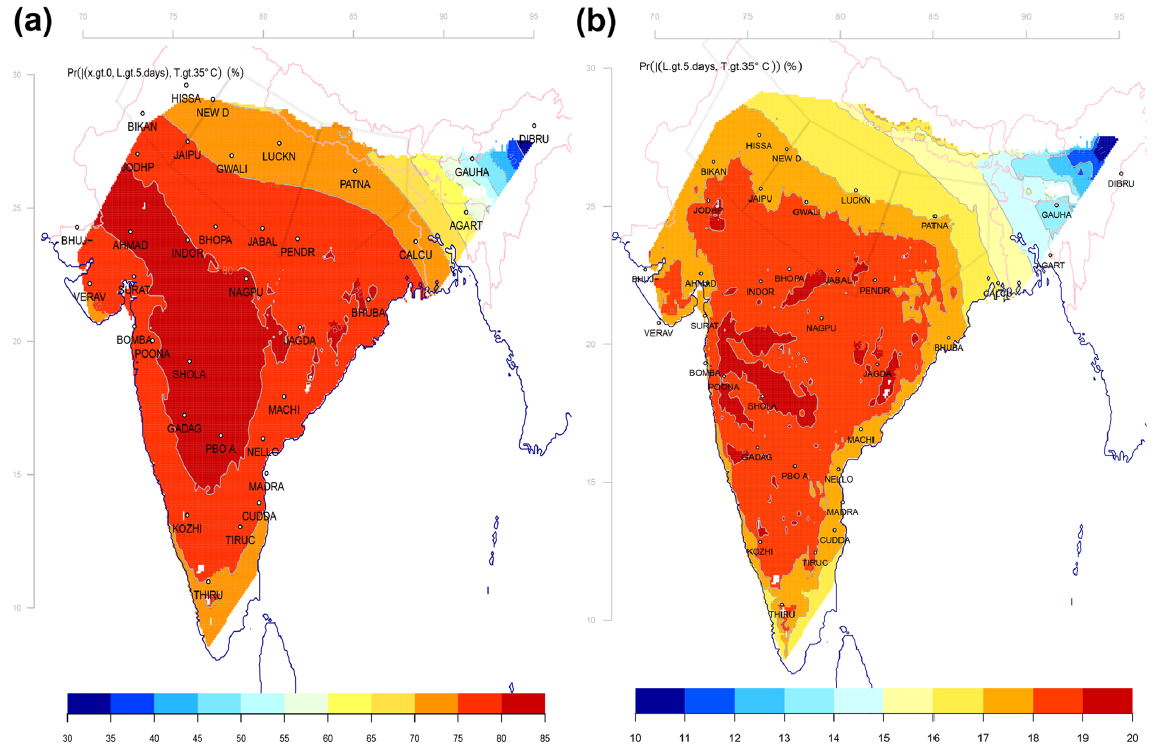
Figure 5. Projected probability of (a) one or more events with daily maximum temperature above 35 ◦ C lasting longer than 5 days during the February–April season in 2100 assuming the RCP4.5 emission scenario and (b) the probability that the heat lasts longer than 5 days given a hot day in 2100 assuming the RCP4.5 emission scenario. The map was generated by gridding estimates shown in the fourth column in Table